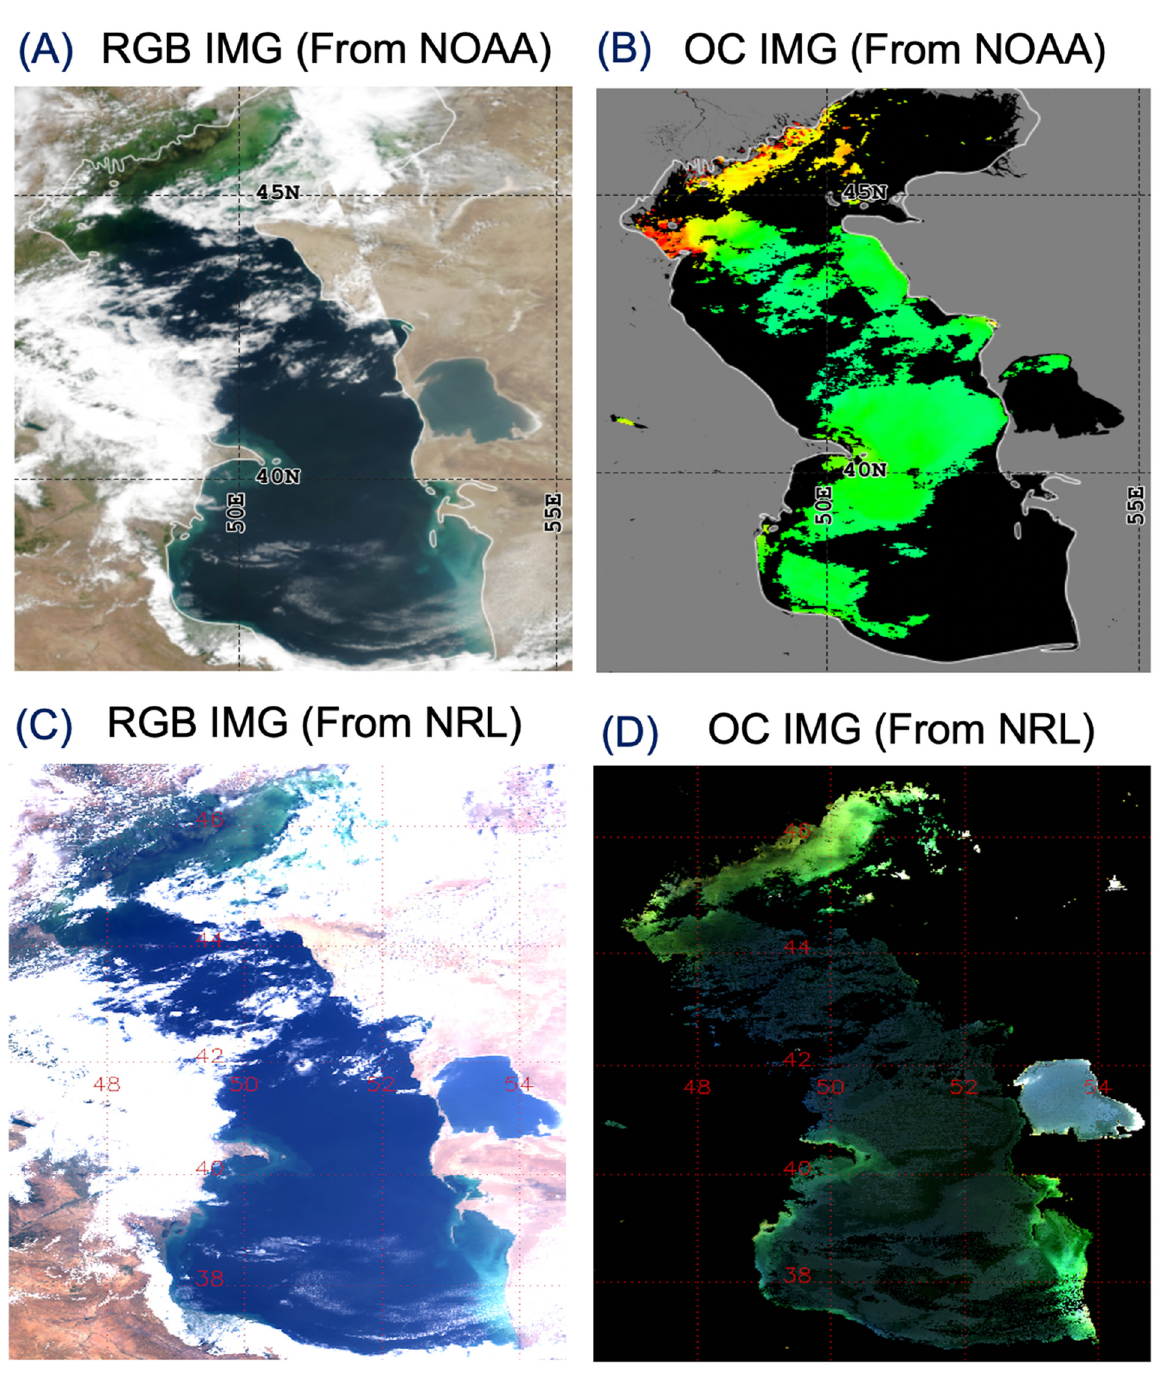
Figure 5. ( A )—a portion of NOAA-posted VIIRS RGB image over the Caspian Sea acquired on July 23, 2022; ( B )—the NOAA-posted Chl-a image; ( C )—the RGB image we obtained through processing the VIIRS radiance and geolocation data sets; and ( D )—our retrieved RGB water leaving reflectance image.